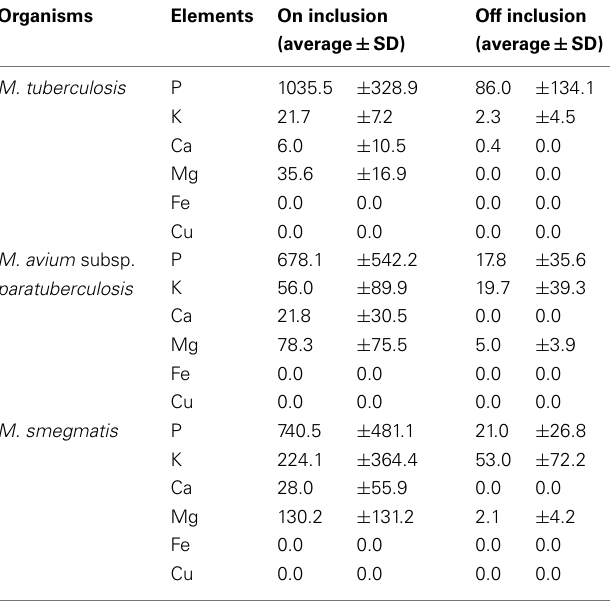
Table 2 | Elemental analysis of Mycobacteria using STEM and EDS.